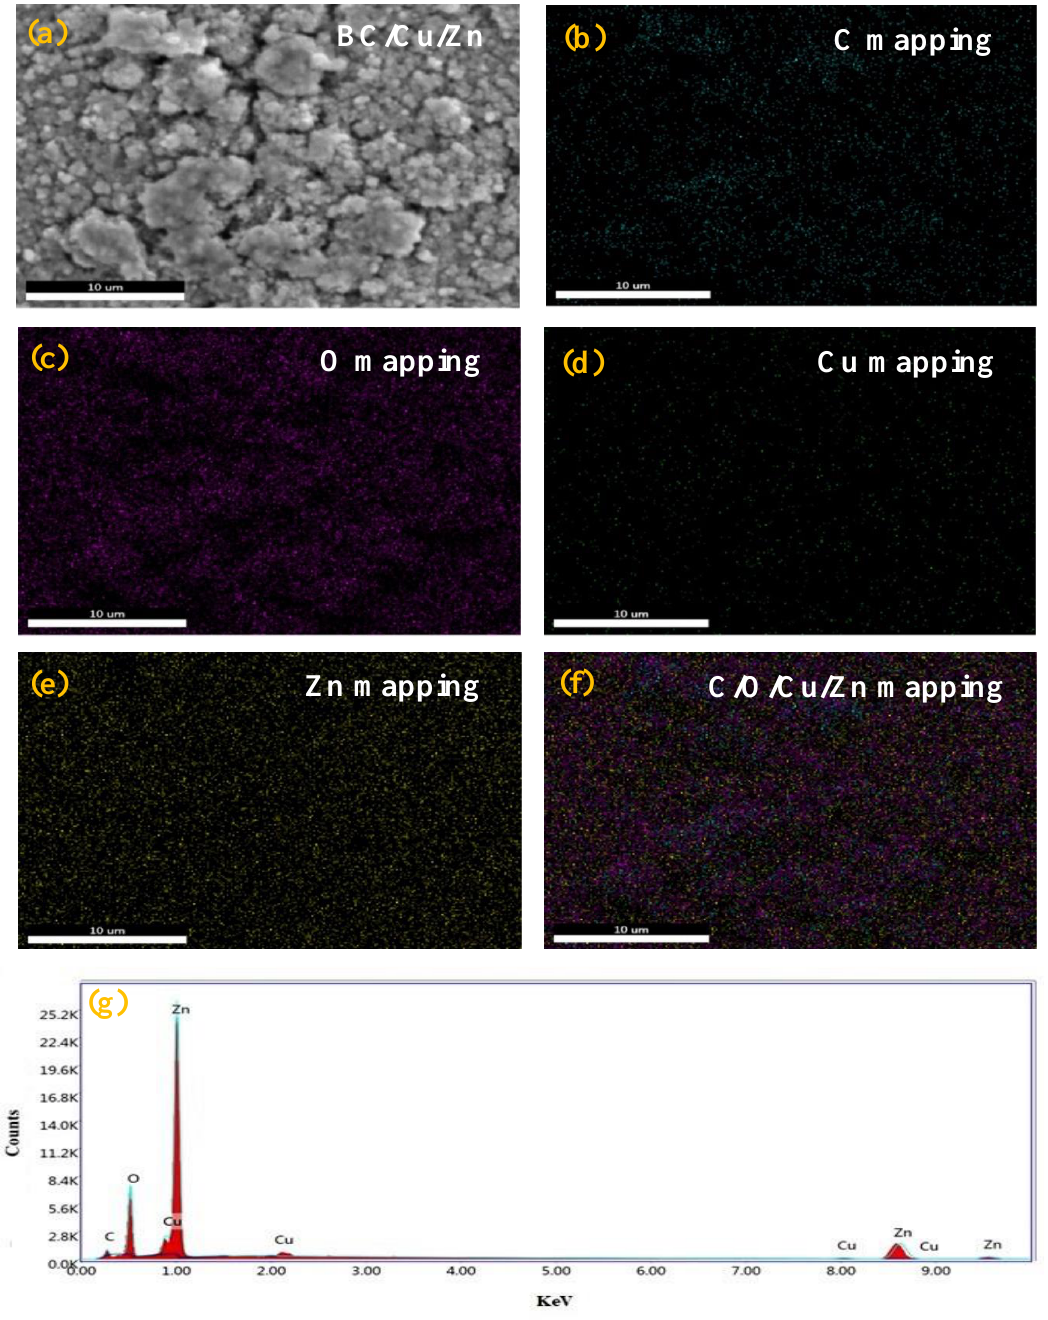
Figure 6. Element distributions in bacterial cellulose / copper / zinc oxide nanocomposite; EDS-SEM ( a – f ) representation of element mapping; ( g ) distinguished peaks of elements.